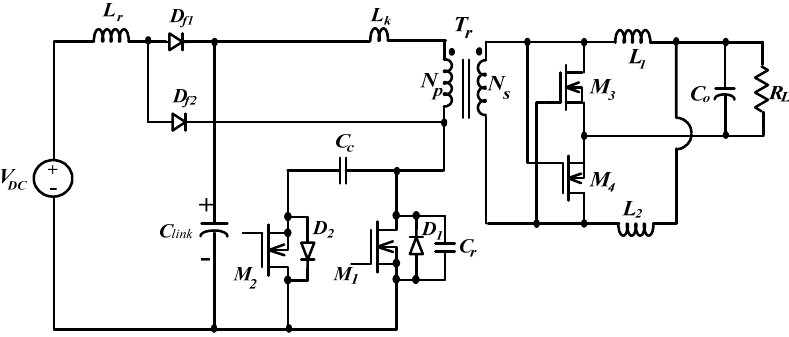
Figure 5. Simplified circuit diagram of the proposed power supply system.